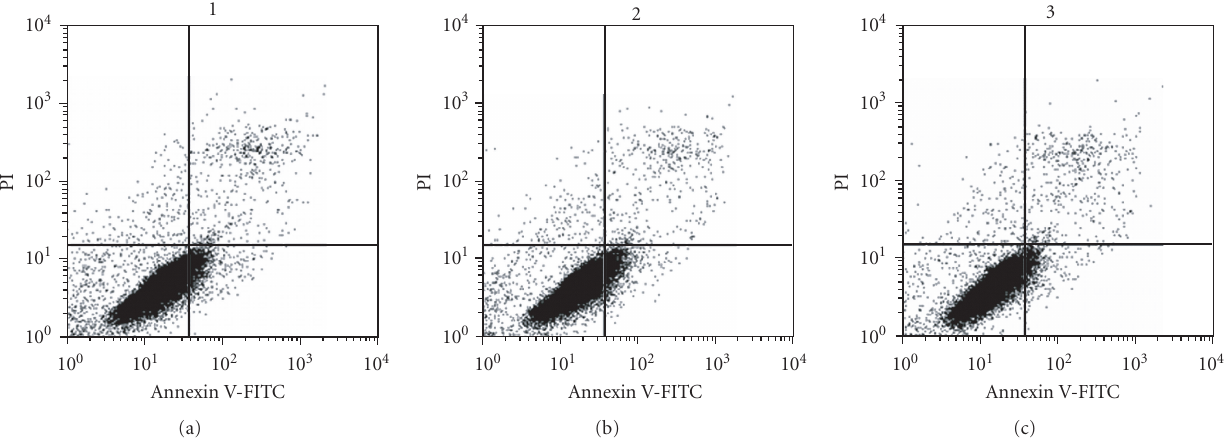
Figure 4: Silencing of the TNFR1 gene reduced the level of apoptosis: (1) blank control group; (2) negative control group; (3) experimental group. The results show no statistically significant di ff erence between the rate of apoptosis in the blank control group and the negative control group. The rate of apoptosis in the experimental group was significantly lower after transfection with TNFR1-siRNA ( P < . 05). Apoptotic cells were detected by flow cytometry. Results are from one representative experiment from a total of three performed.